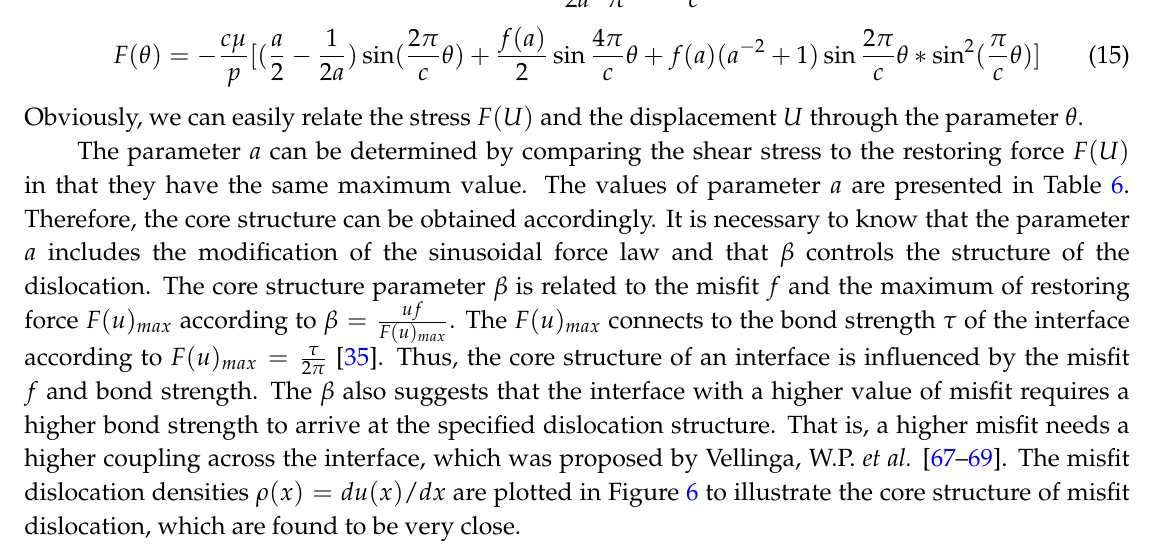
Table 6. The unstable stacking fault energy γ us (J/m 2 ), Burgers vectors b (Å), the misfit dislocation energy E mis (J/m 2 ), interface energy E int (J/m 2 ), the work of adhesion W ad (J/m 2 ) for semicoherent and the work of adhesion difference ∆ W ad (J/m 2 ) between coherent and semicoherent